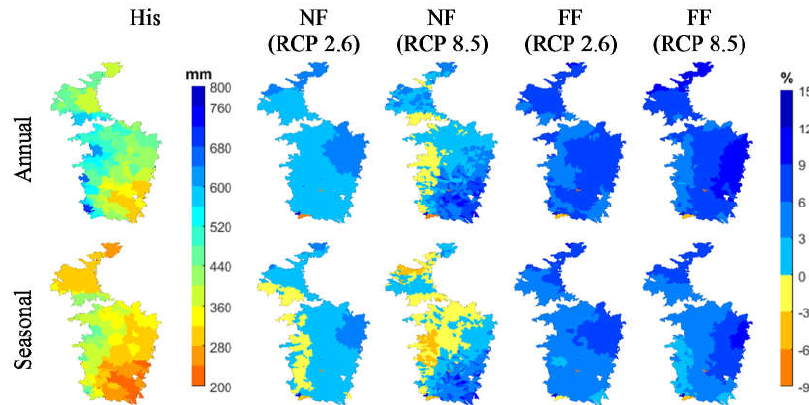
Figure 3. Spatial distribution of mean seasonal and annual precipitation and their projected changes (%) in the future under RCP 2.6 and 8.5, where His indicates historical period (1983–2007), NF indicates near future (2010–2034) and FF indicates far future (2040–2064).